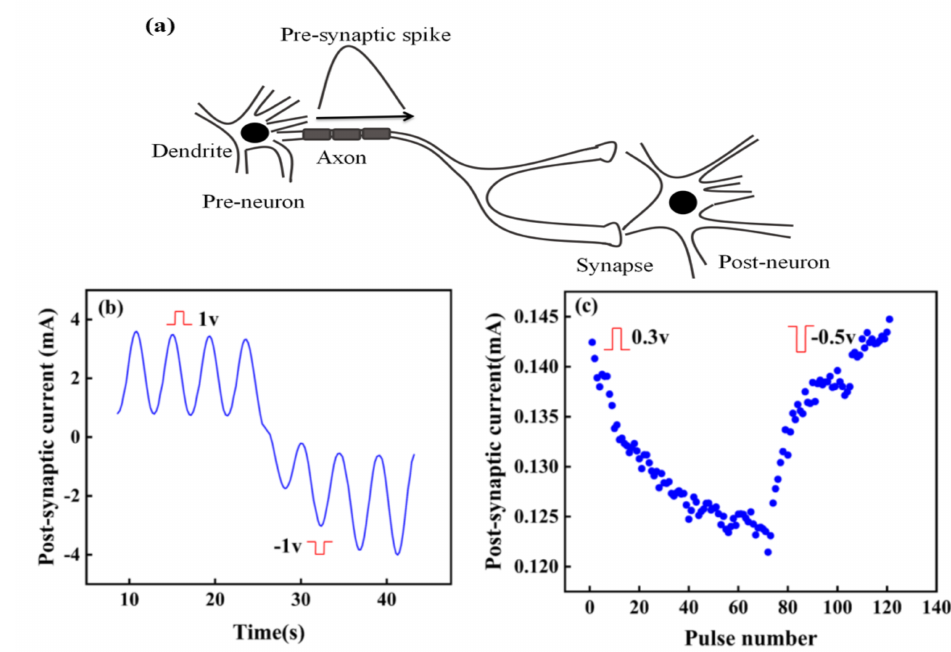
Figure 5. ( a ) Signal transmission between two neurons; ( b ) Response of current to time under continuous positive and negative pulses. ( c ) Potentiation and depression of